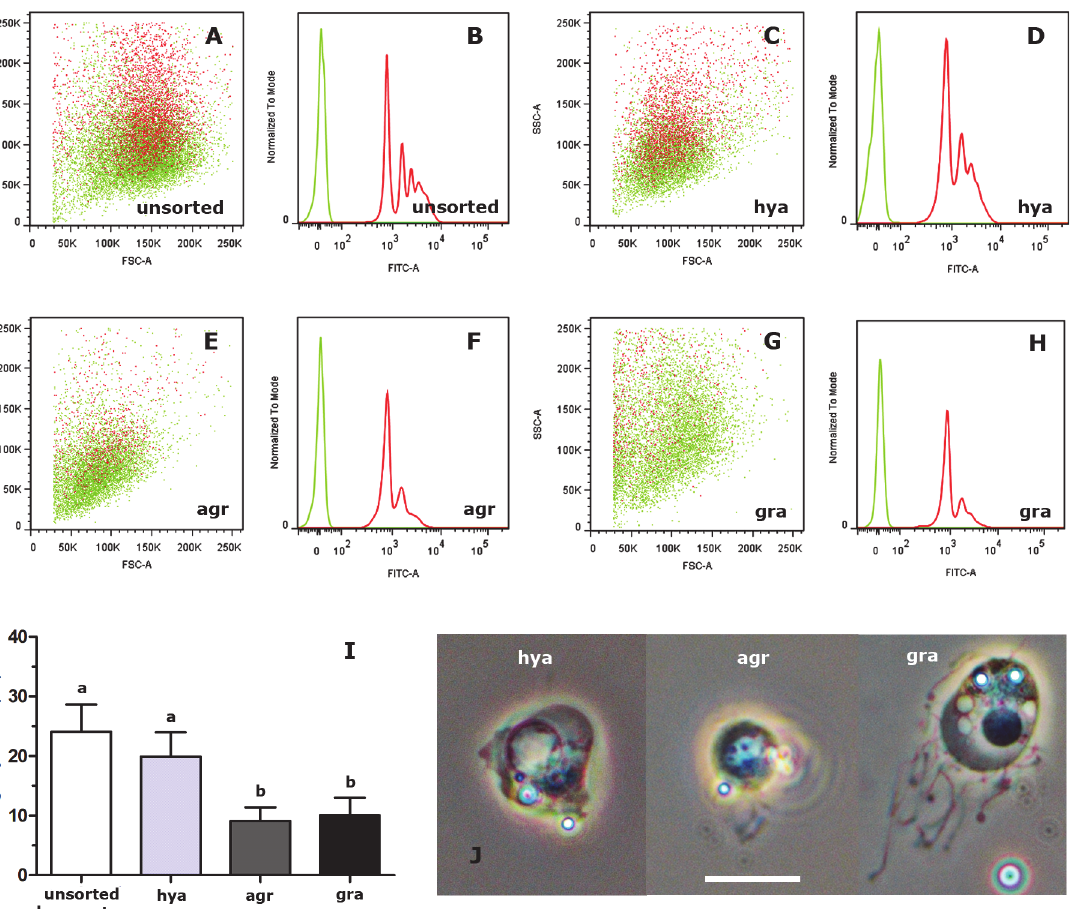
Fig 7. In vitro phagocytosis of fluorescent beads by sorted and unsorted circulating hemocytes. (A) Dot plot of cell size vs . complexity-granularity of unsorted circulating hemocytes exposed to fluorescent beads. In this and in panels C, E and G, red dots indicate phagocytic hemocytes associated to fluorescent beads, while green dots indicate non phagocytic ones. (B) Histograms of the sample shown in A: in this and in panels D, F and H, red and green lines show the distribution of phagocytic and non-phagocytic hemocytes, respectively. The red histogram indicates the existence of 4 – 5 hemocyte populations associated to different amounts of fluorescent beads. (C) Dot plot of size vs . complexity-granularity of sorted hyalinocytes exposed to fluorescent beads. (D) Histograms of the hyalinocyte sample shown in C: the red histogram indicates the existence of 3 – 4 hyalinocytes populations associated to different amounts of fluorescent beads. (E) Dot plot of size vs . complexity-granularity of sorted agranulocytes exposed to fluorescent beads. (F) Histograms of the agranulocyte sample shown in E: the red histogram indicates the existence of 2 – 3 agranulocyte populations associated to different amounts of fluorescent beads. (G) Dot plot of size vs . complexity-granularity of sorted granulocytes exposed to fluorescent beads. (H) Histograms of the granulocyte sample shown in E: the red histogram indicates the existence of 2 – 3 granulocyte populations associated to different amounts of fluorescent beads. (I) Phagocytosis index of unsorted circulating hemocytes and of sorted hyalinocytes, agranulocytes and granulocytes (means ± SE; N = 6; different letters indicate statistically significant differences, one-way ANOVA, Tukey test). (J) Phase contrast micrographs of sorted phagocytic hemocytes. Abbreviations: agr , agranulocytes; gra , granulocytes; hya , hyalinocytes. Scale bar represents 10 μ